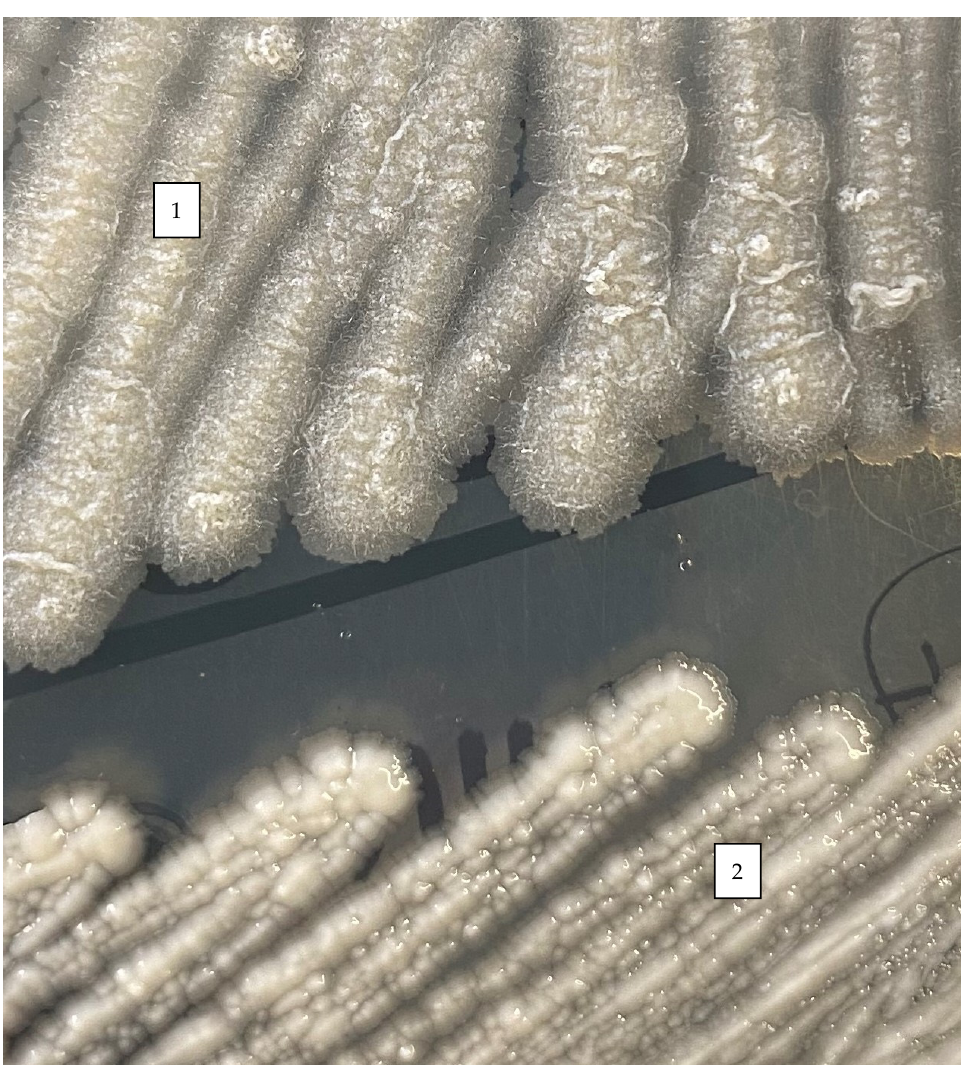
Figure 2. Rough ( 1 ) and smooth ( 2 ) phenotypes of colonies of M. abscessus in Middlebrook 7H10 agar after 5 days of incubation at 30 °C.